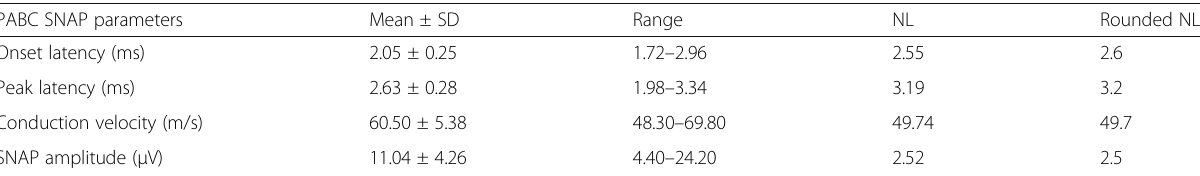
Table 1 Reference values of the posterior antebrachial cutaneous sensory nerve action potential parameters (120 upper limbs from 60 apparently healthy